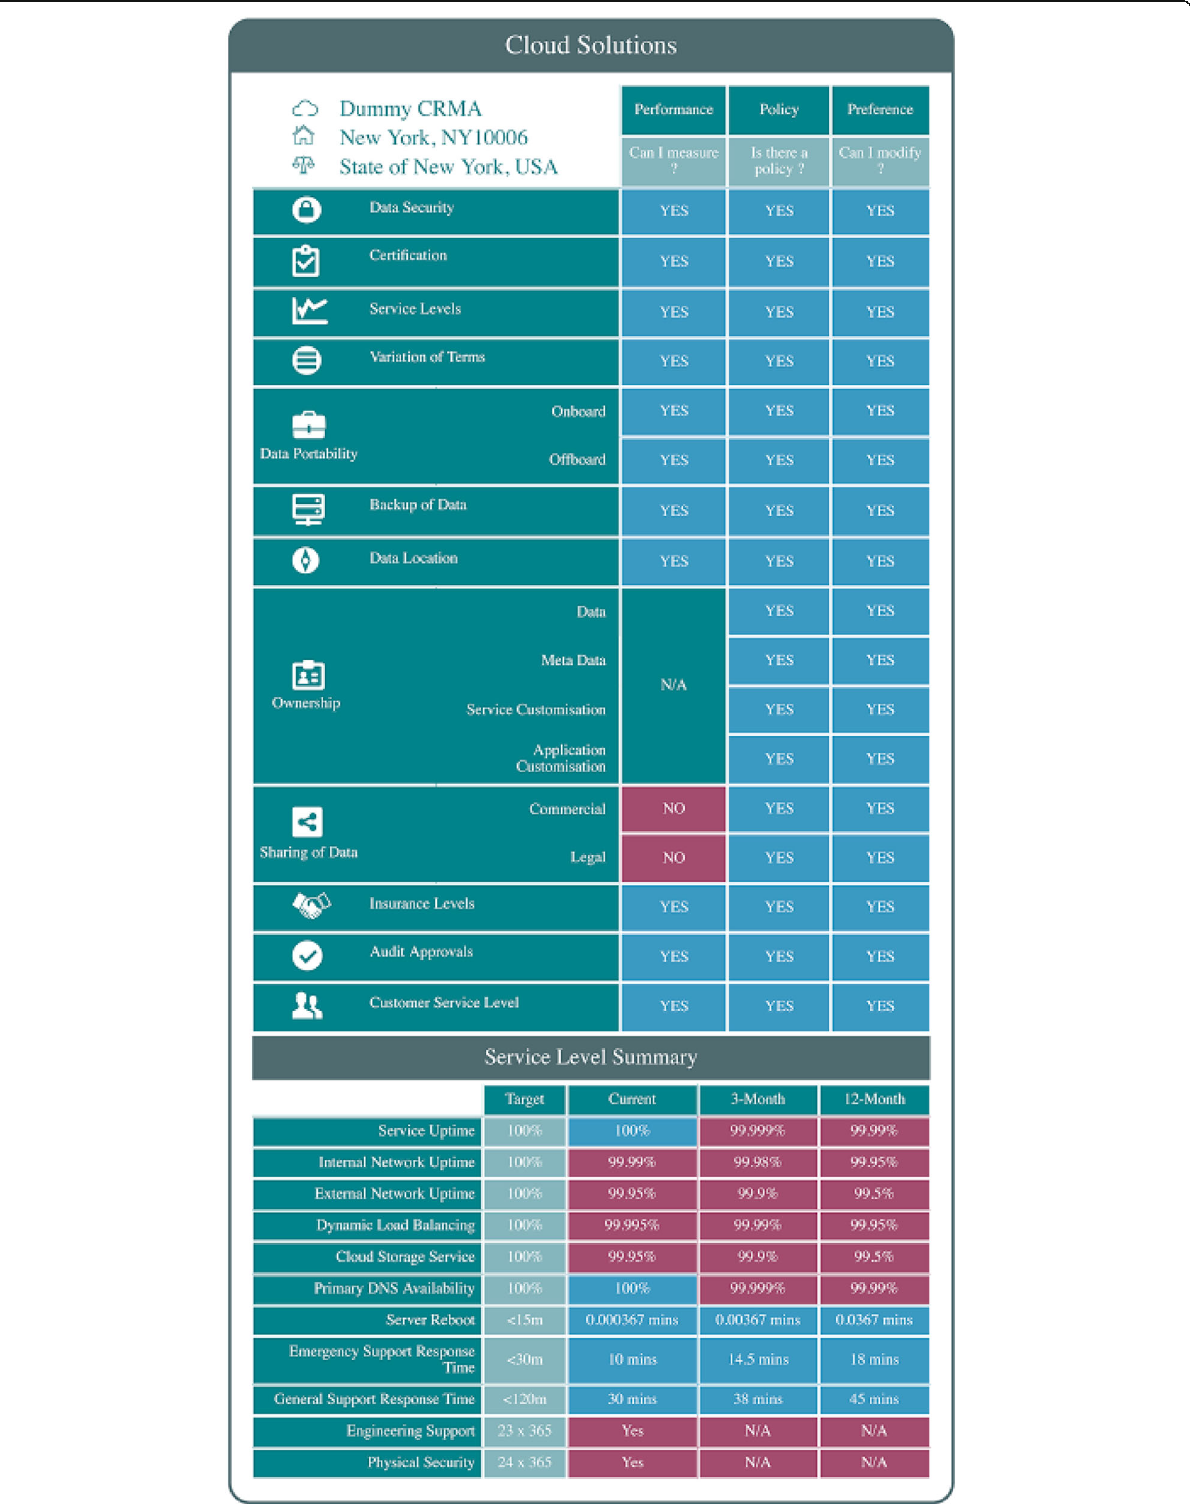
Fig. 1 Exemplar Positive CTL. An exemplar positive CTL was developed to explore the influence of positive information regarding the CSP on individuals ’ trust